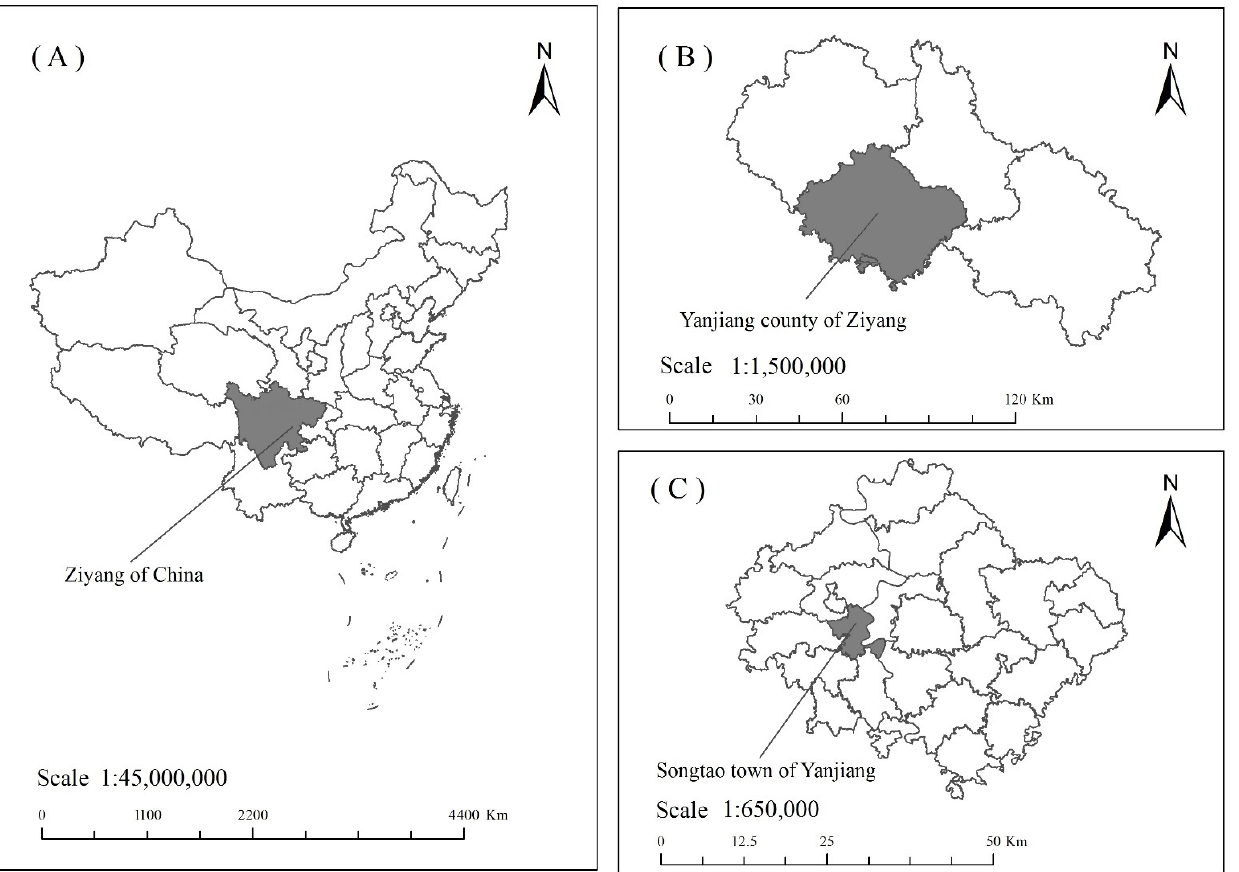
Figure 1. The location of the study area. Table 1. The soil bulk density, pH and concentrations of soil organic matter (SOM), total phospho- (AN), and available potassium (AK) (mean ± SD) from different soil layers in the study